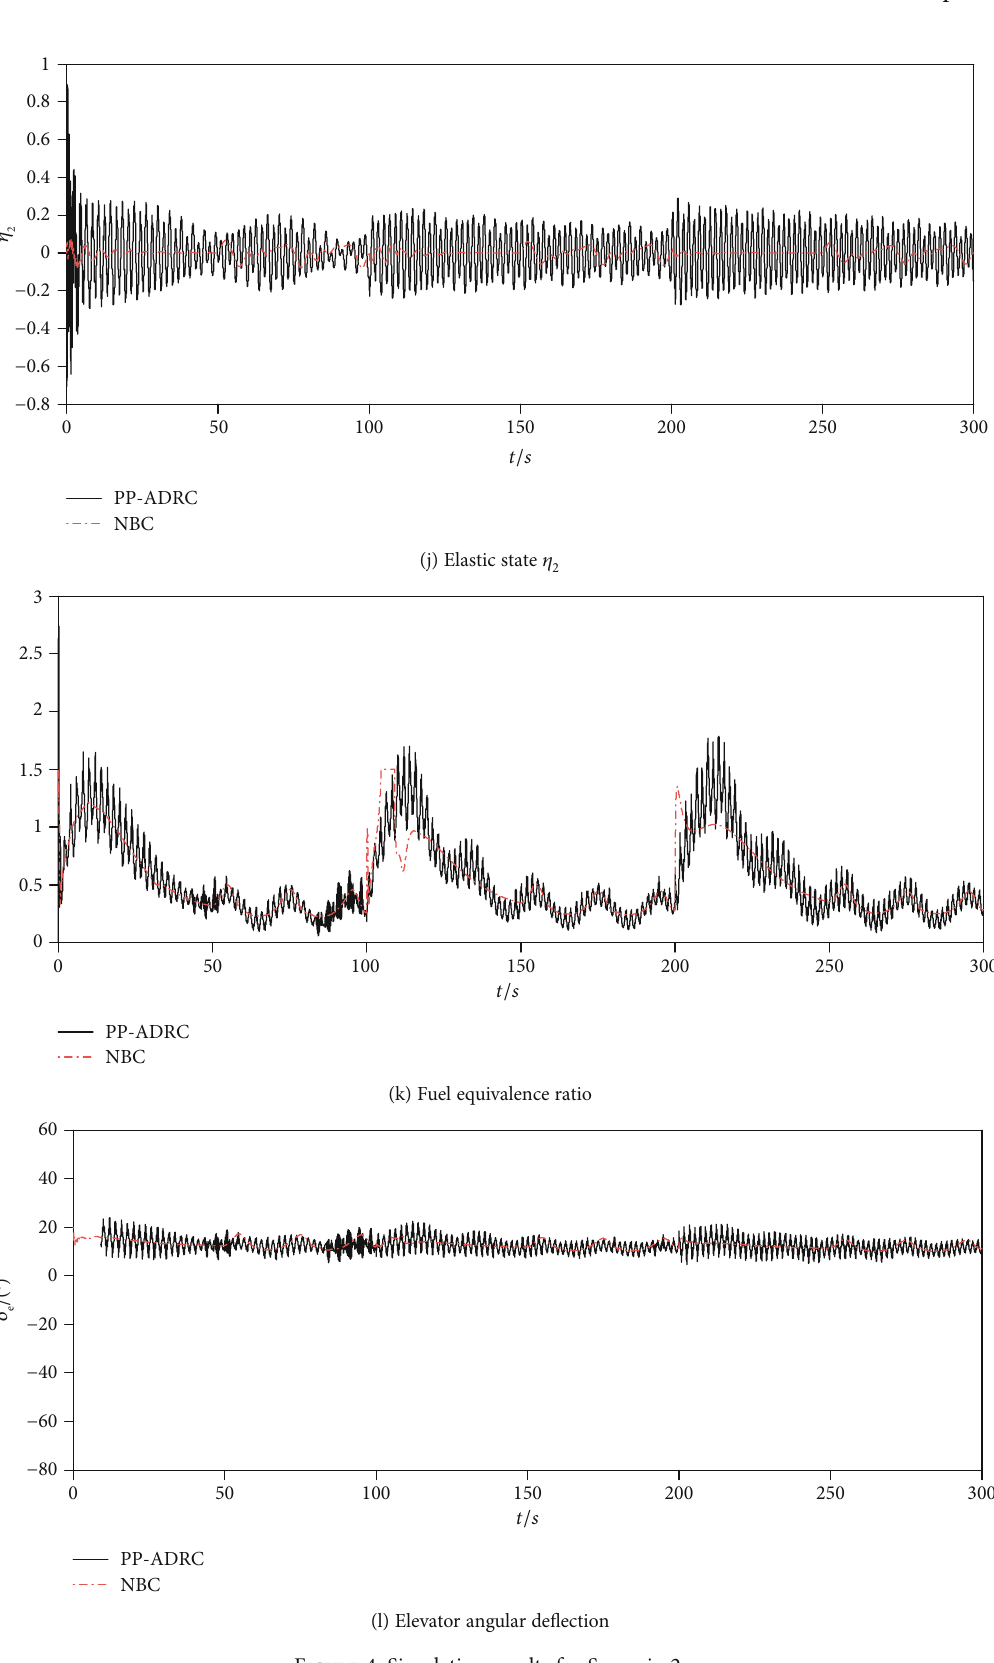
Figure 4: Simulation results for Scenario